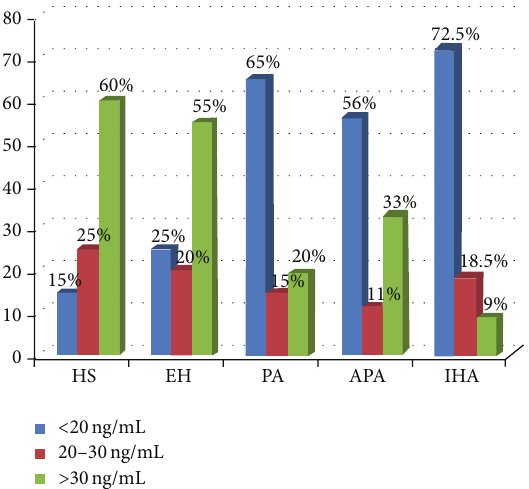
Figure 1: Plasma levels of 25(OH)-vitamin D in all subjects enrolled. HS: healthy subjects; EH: essential arterial hypertension; PA: primary aldosteronism; APA: aldosterone-producing adrenal adenoma; IHA: idiopathic bilateral